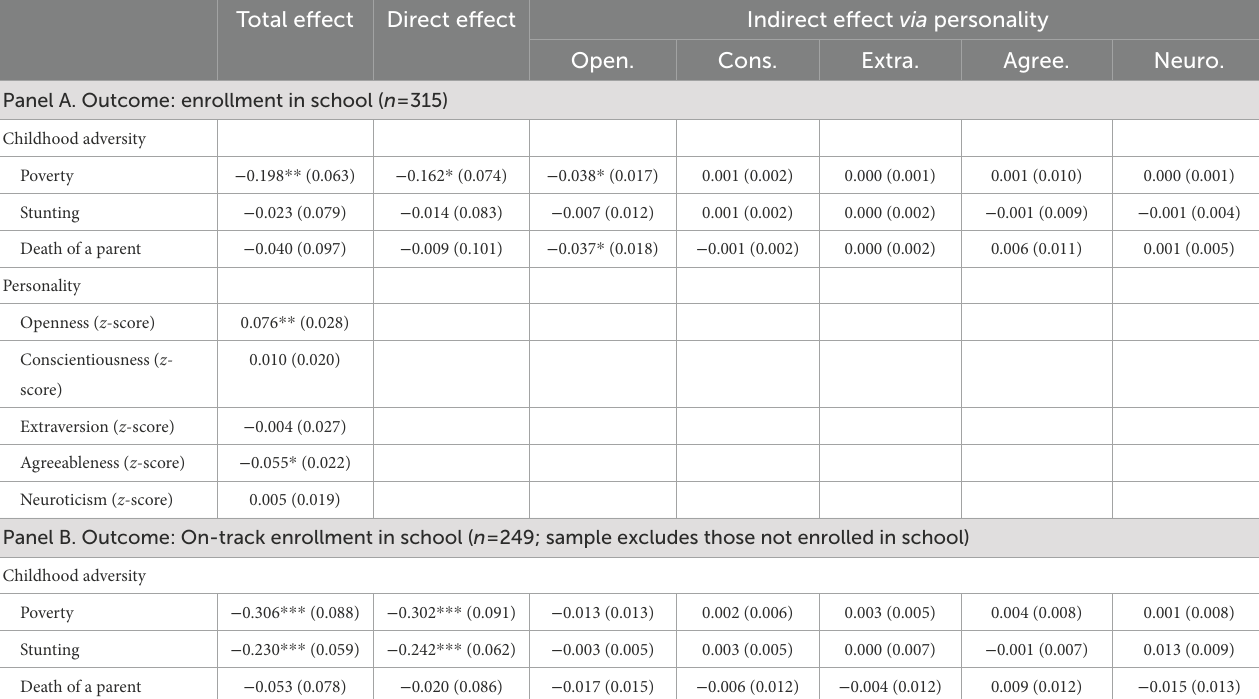
TABLE 3 Direct and indirect effects on educational